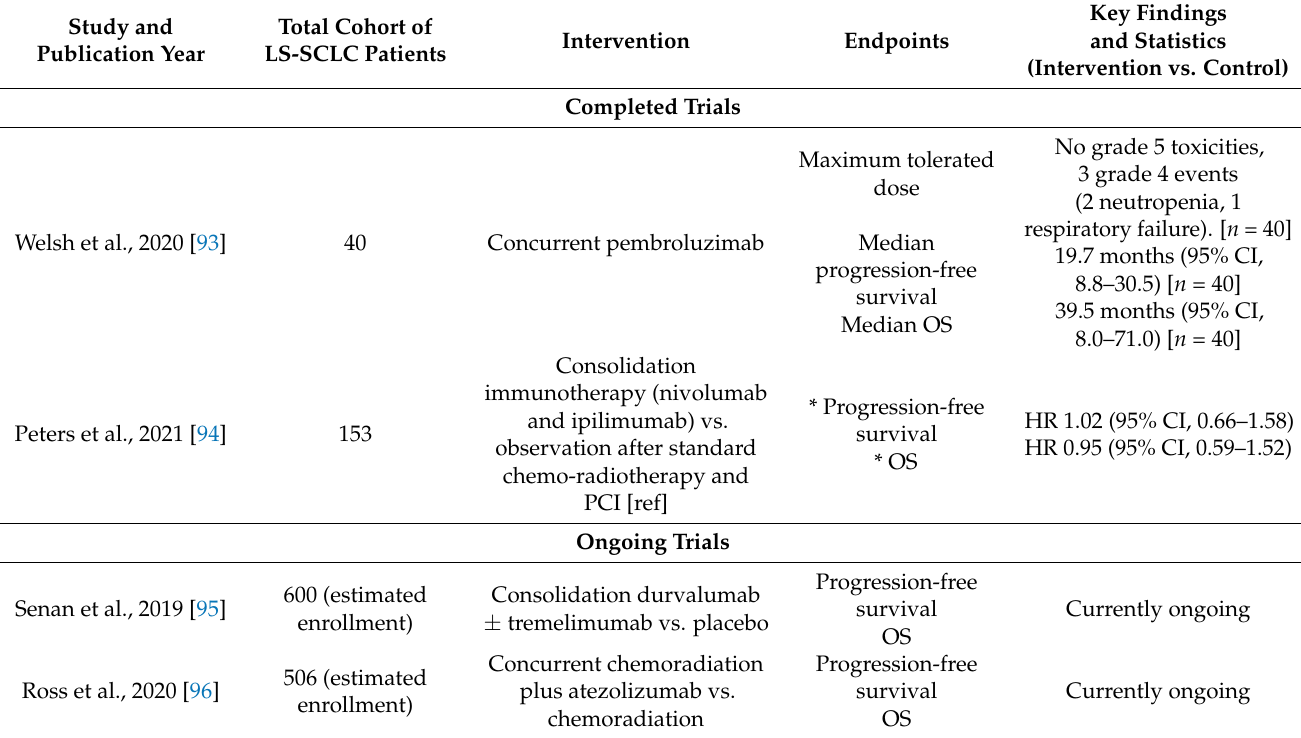
Table 3. Ongoing and completed prospective studies for immunotherapies in LS-SCLC.